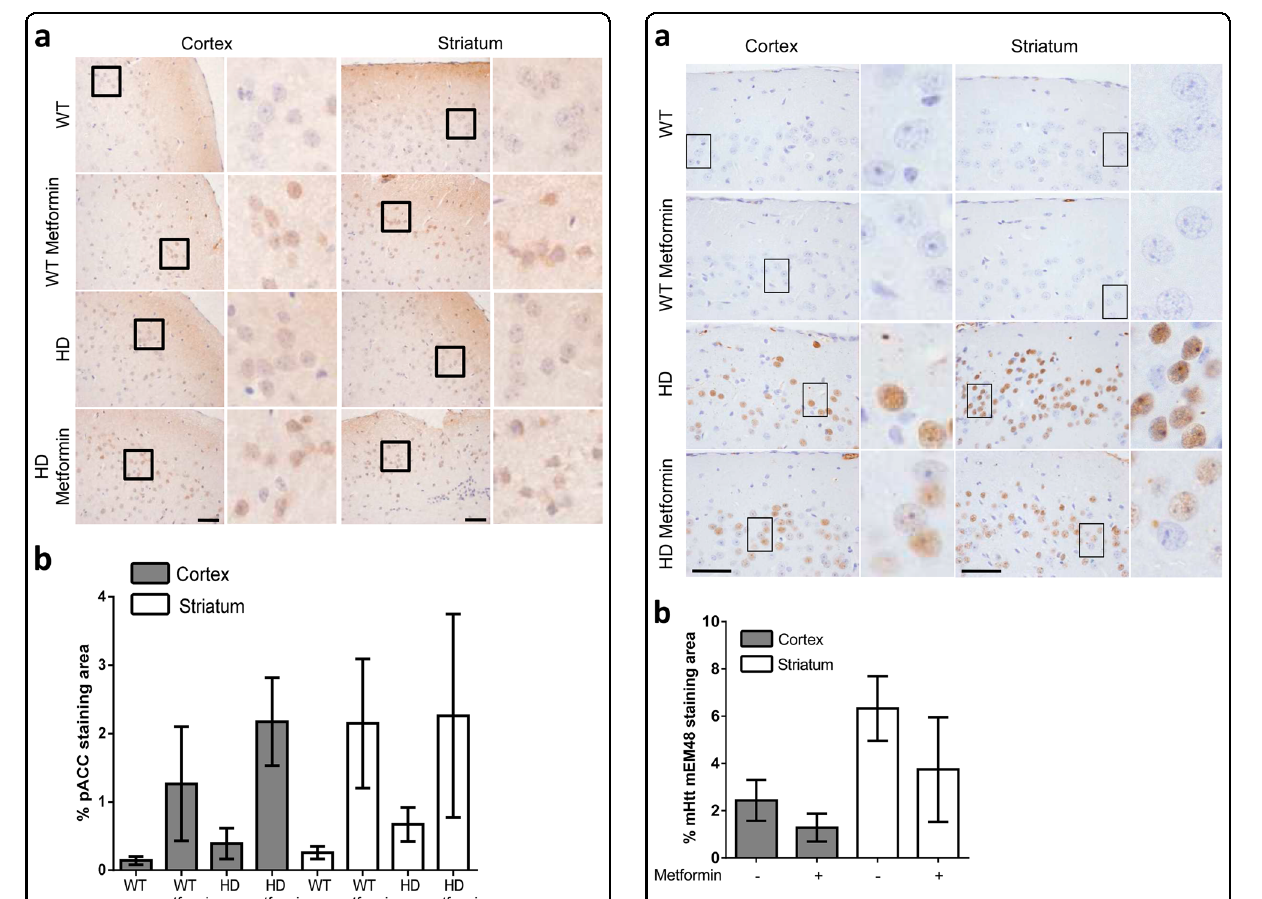
Fig. 4 Mutant huntingtin aggregation in the brain tissue of six- month-old zQ175 mice is reduced by metformin treatment. a Immunohistochemical (IHC) staining illustrates the expression levels of mutant huntingtin (mHTT) in the cortex and striatum of zQ175 mice and their corresponding controls (wild type (WT)). Representative images of each condition are shown (bars: 50 µm). Boxed areas are enlarged, with a higher magni fi cation, on the right side of each image. b The bottom panel shows a semiquantitative analysis of IHC staining using the ImageJ software. Samples from four independent mice from each group were analyzed, which generated 10 cortex and 8 striatum pictures from untreated zQ175 (Huntington disease (HD)) mice and 10 cortex and 7 striatum pictures from HD-treated (HD metformin) mice. The analyzed area in each picture was 90,488 μ m 2 . HD mice treated with metformin showed fewer mHtt aggregates ( p = 0.00243), and the reduction in the aggregates was more pronounced in the striatum of these mice ( p < 0.001). Values are the mean, and bars indicate the con fi dence interval (95%